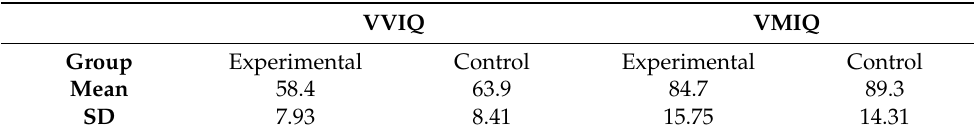
Table 2. Participants’ questionnaire scoring.